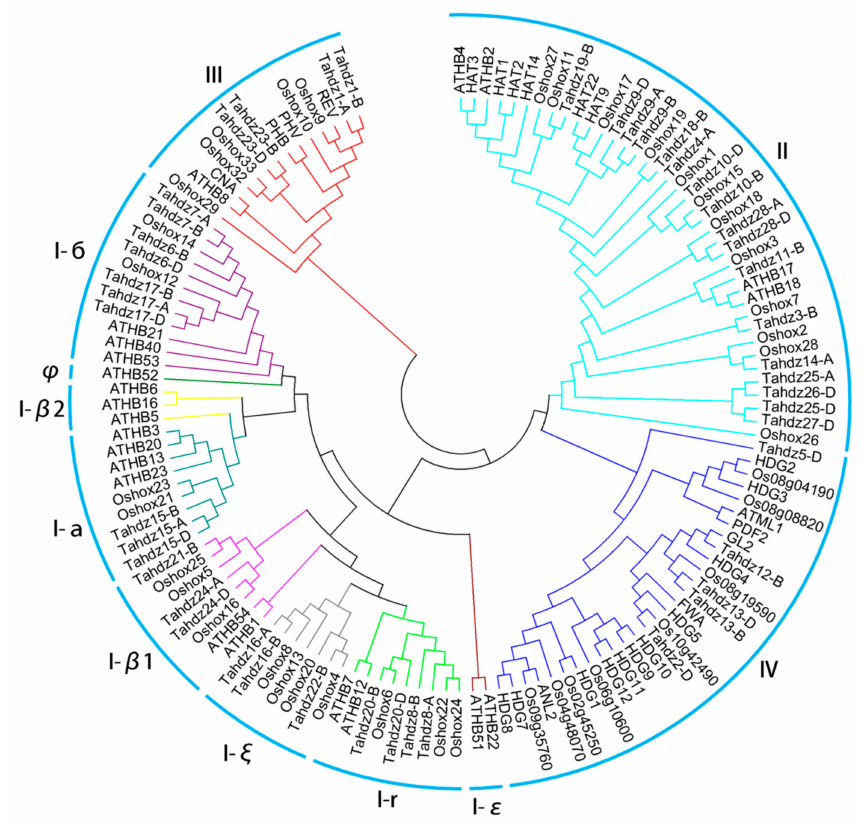
Figure 2. Phylogenetic analysis of HD-Zip proteins among wheat (46), Arabidopsis (48) and rice